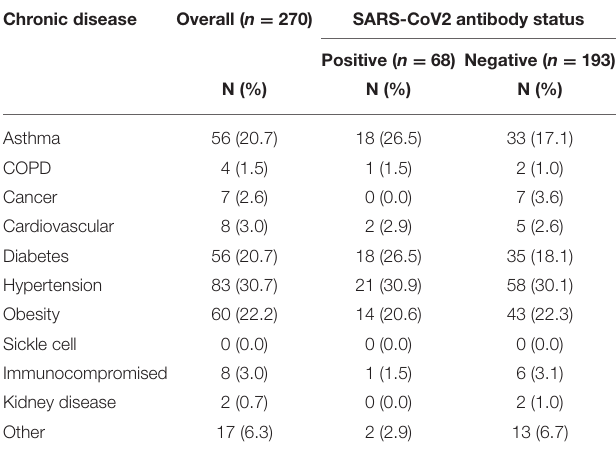
TABLE 4 | Chronic diseases, TX CARES, all phase 1 participants, 2020. Chronic